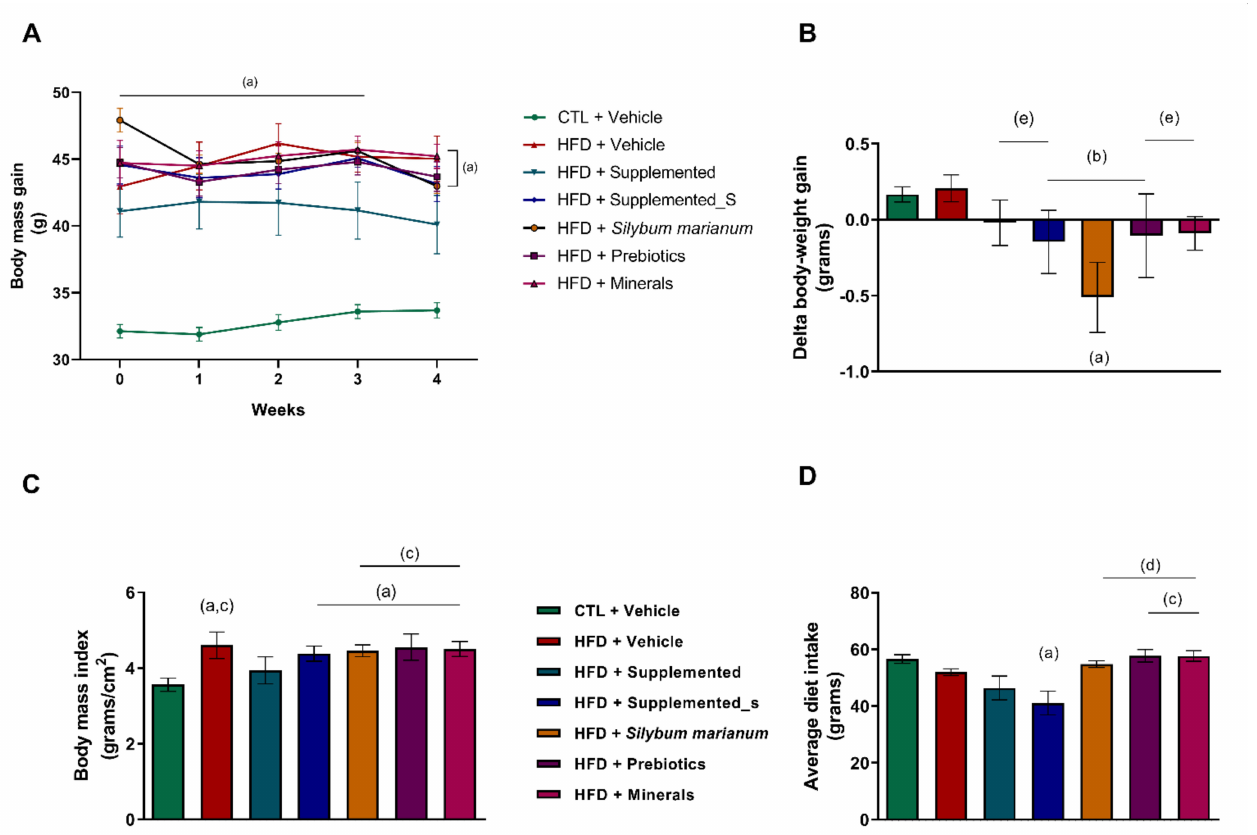
Figure 2. Body measurement data. ( A ) Weekly body mass gain; ( B ) Delta body weight gain; ( C ) Normalized body weight gain; ( D ) Average dietary intake. Significant p < 0.05 in one-way ANOVA followed by Tukey’s post-hoc test (n = 4–8 per group): (a) versus CTL + Vehicle; (b) ver- sus HFD + Vehicle; (c) versus HFD + Supplemented; (d) versus HFD+Supplemented_S; (e) versus HFD+ Silybum marianum . HFD = high-fat diet. Values are means ±